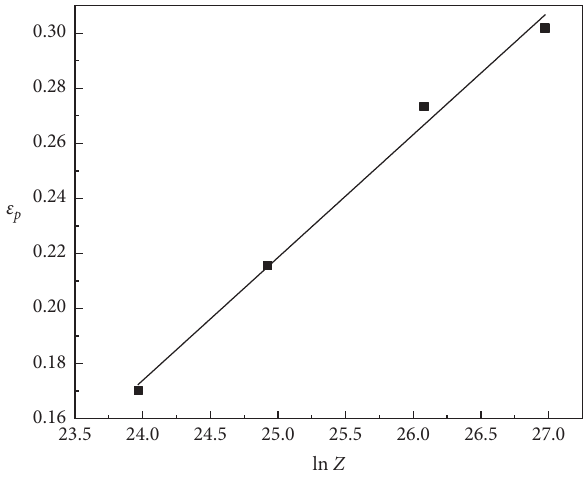
Figure 8: Plot of ε